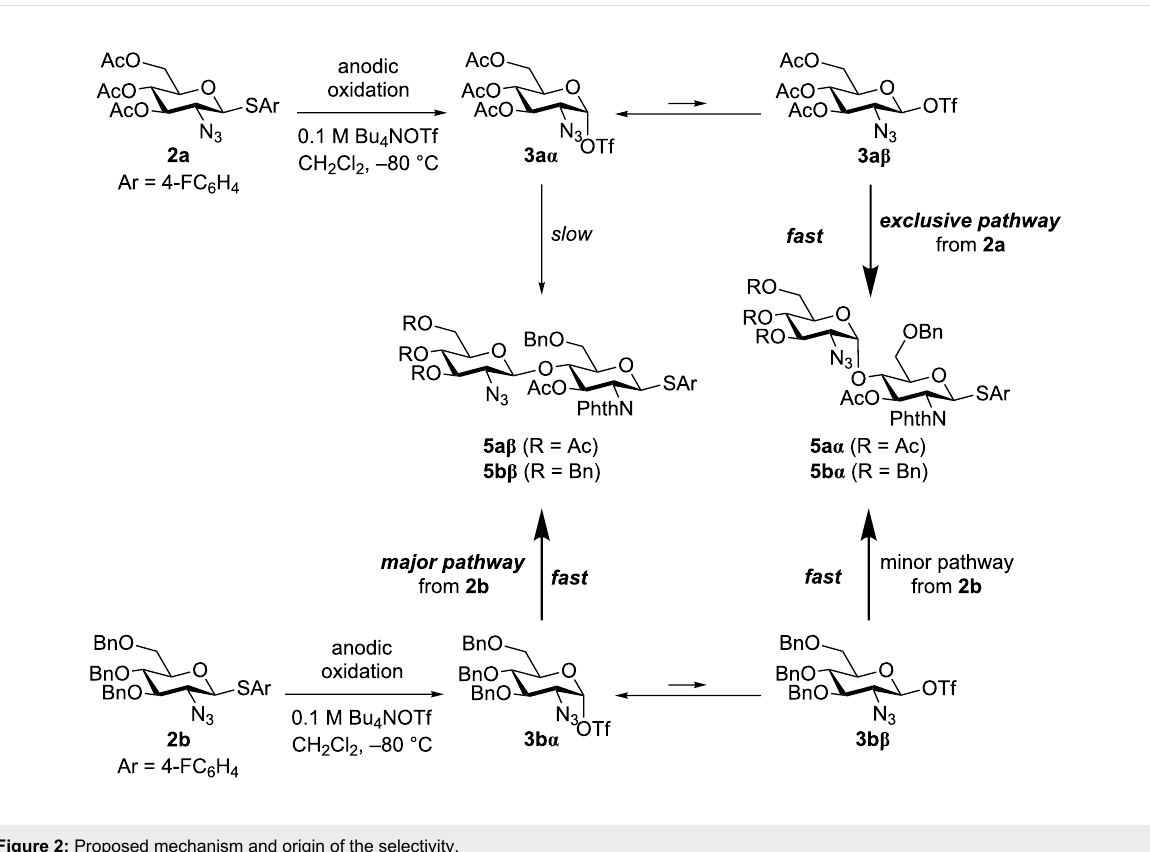
eluent), the pure β -disaccharide isomer 5b β was obtained as colorless crystals after careful separation by silica gel chroma-